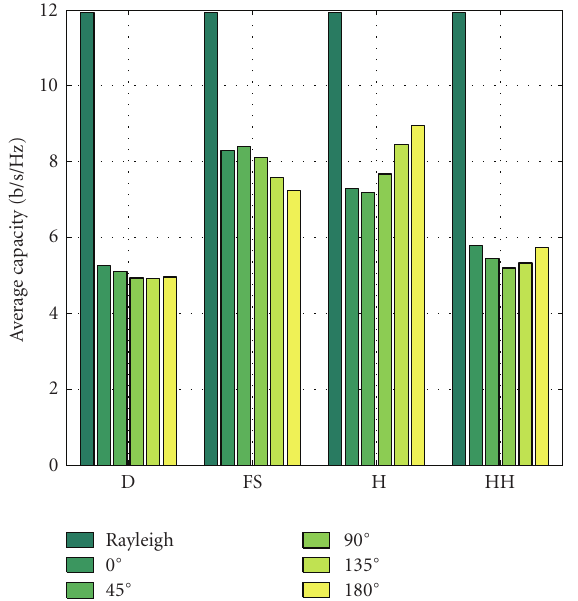
Figure 8: Average channel capacity in the di ff erent usage scenarios at di ff erent user orientations.